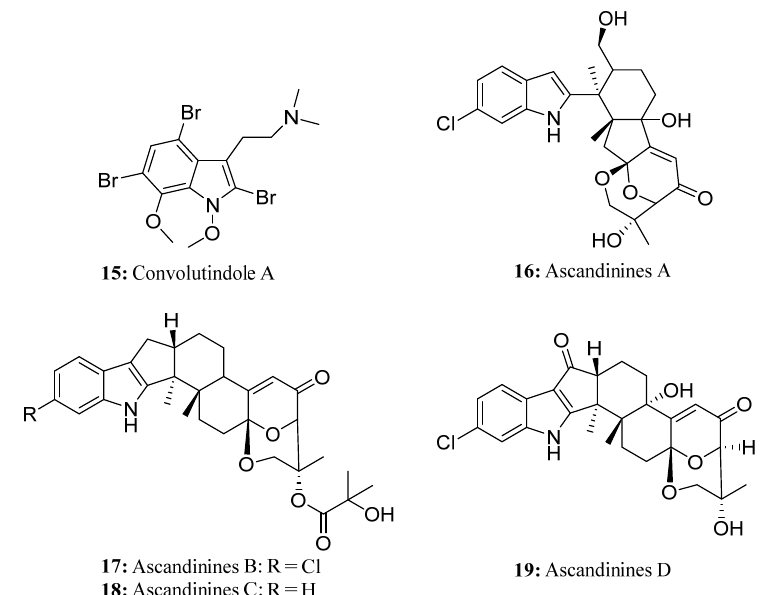
Figure 3. The structure of compounds 15 – 19 .